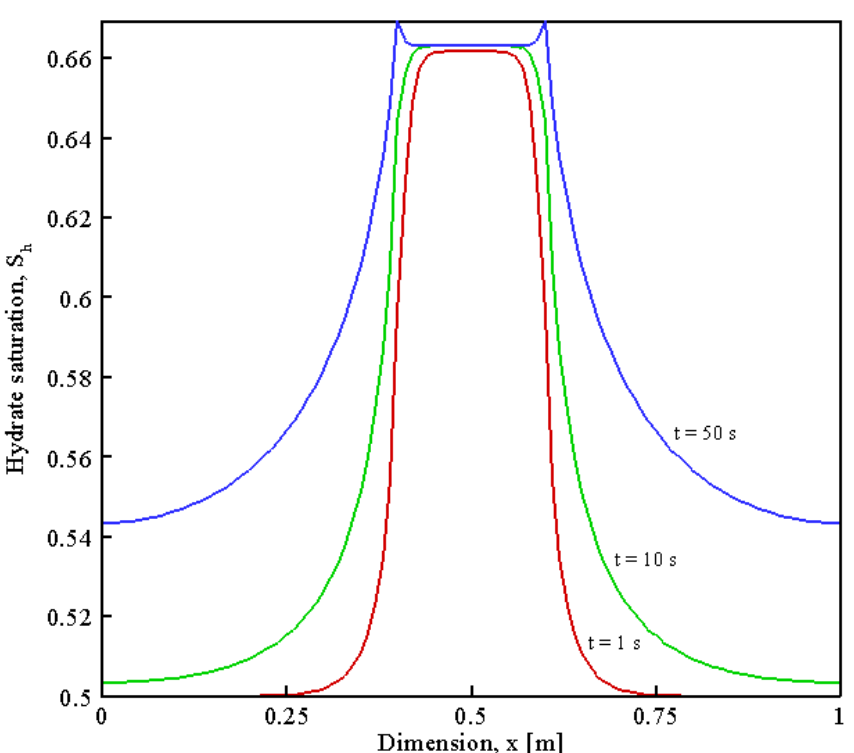
x at the different moments of